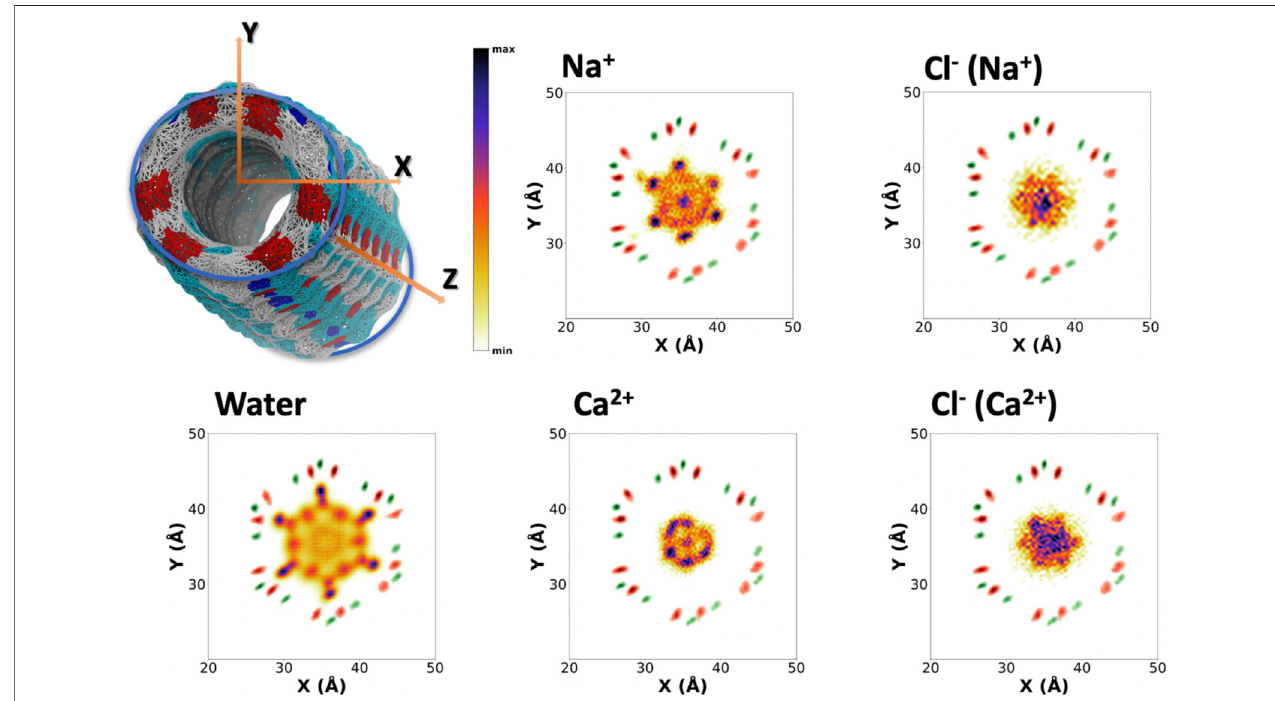
FIGURE 4 | Positional probability distributions represented as heatmaps (increasing from orange to blue) at the XY plane for Na + , Ca 2+ , and their correspondent counter Cl − anions. Water (from the blank trajectory) is shown at the down left of the fi gure. The averaged position of alpha carbons (green) and carbonyl groups (red) is also represented as a reference. These 2D-heatmaps were generated using the last 180 ns of the MD simulations.